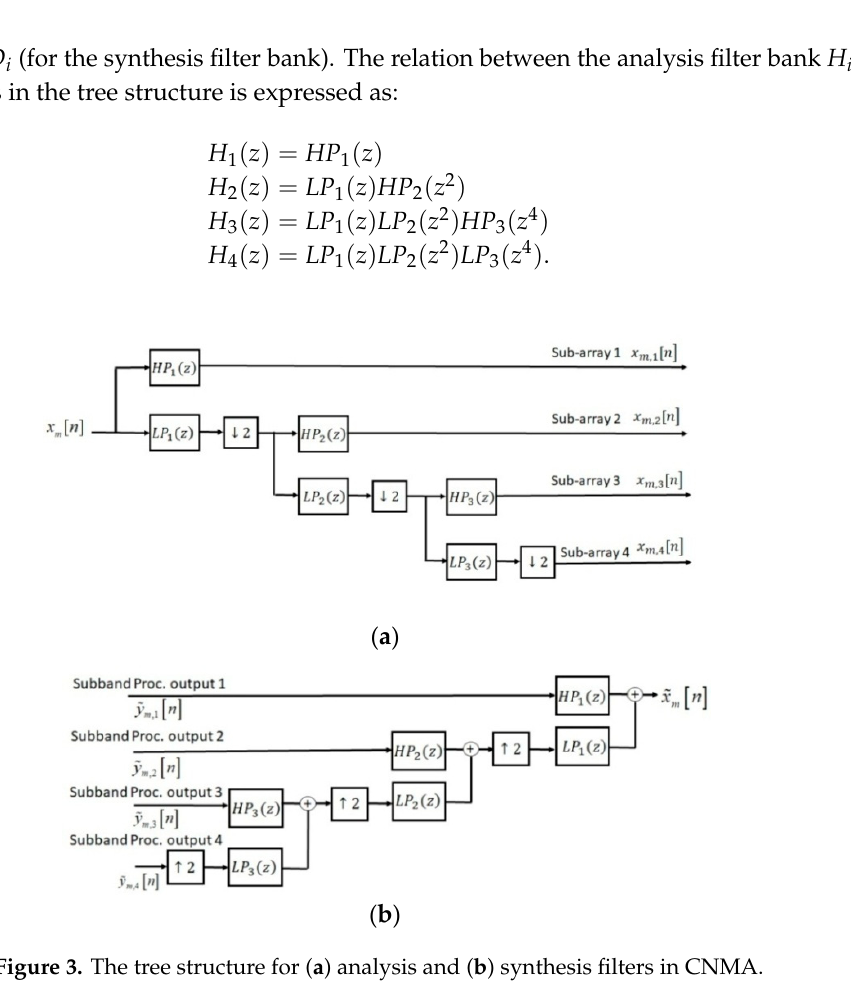
Figure 3. The tree structure for ( a ) analysis and ( b ) synthesis filters in CNMA.